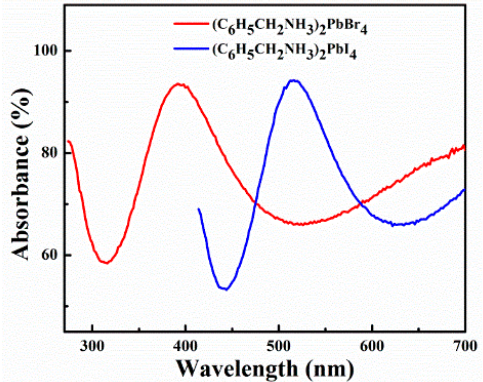
Figure 6. The absorption spectra of the perovskites (C 6 H 5 CH 2 NH 3 ) 2 PbBr 4 (red curve) and (C 6 H 5 CH 2 NH 3 ) 2 PbI 4 (blue